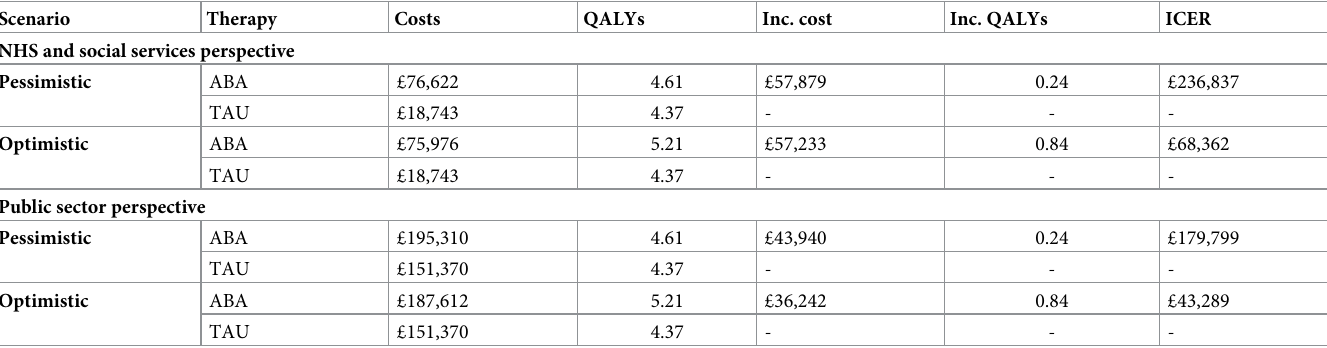
Table 2. Base-case results (deterministic